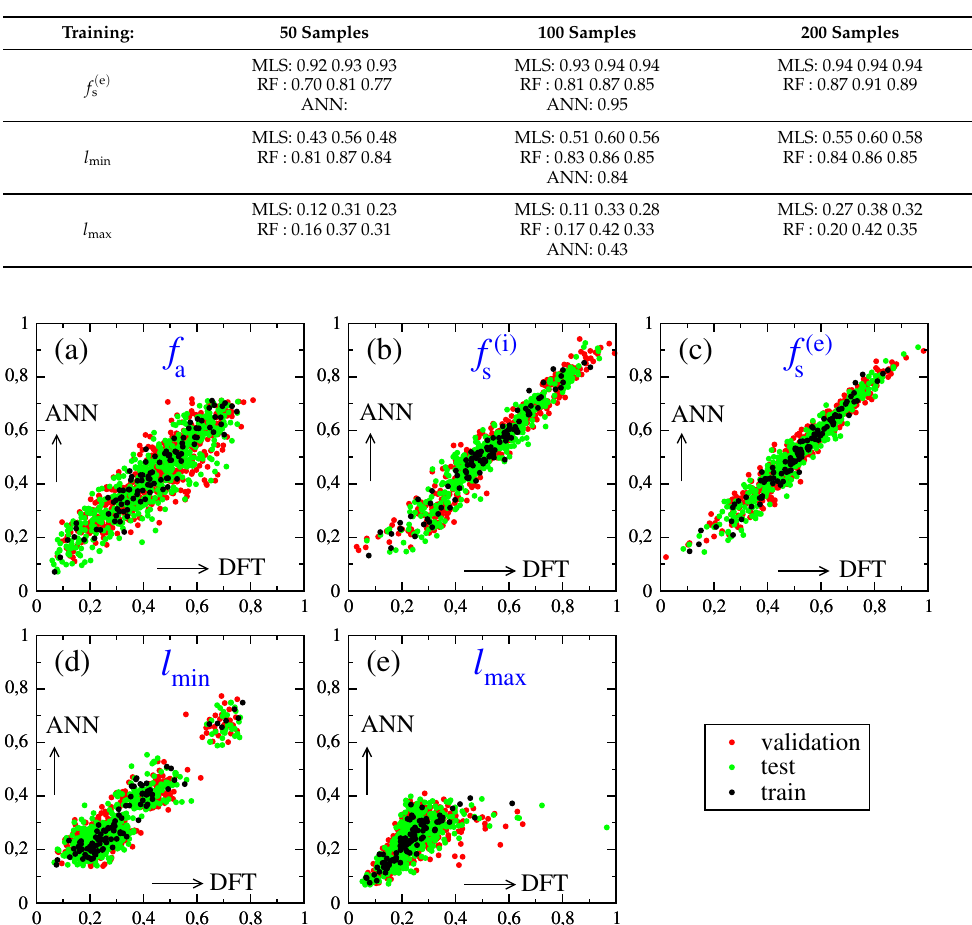
Figure 8. Regression data obtained using ANN models: ( a ) optical absorption index f a ; ( b , c ) stability ( i / e ) indices for the intrinsic/extrinsic mechanisms, f s ; ( d , e ) minimum/maximum bond